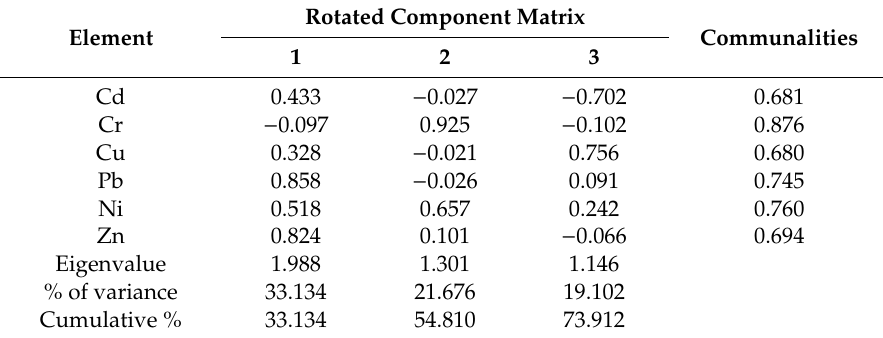
Table 2. Total principal component analysis (PCA) variance for heavy metals.